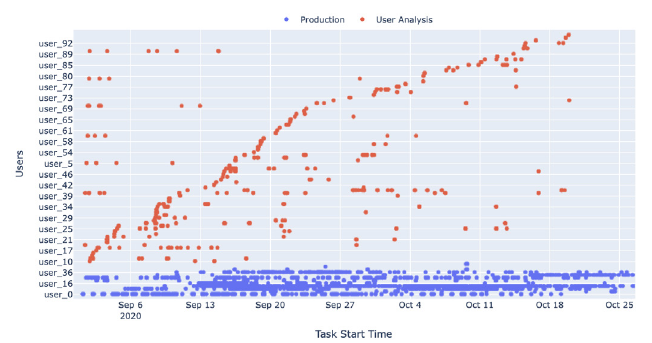
Figure 6: Start time of production and user analysis